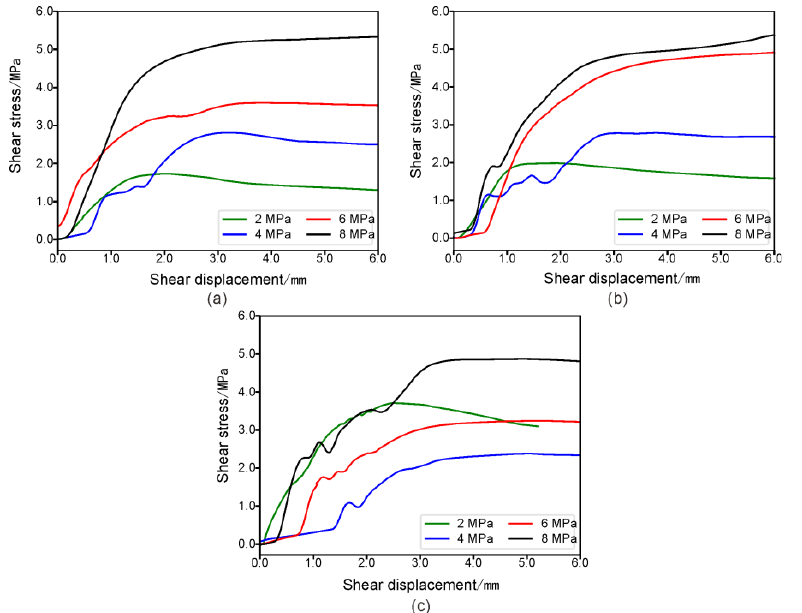
Figure 12. The shear stress–shear displacement curves of the tensile fault surface filled with three types of fault gouge (( a ) is No. 1 fault gouge, ( b ) is No. 2 fault gouge, ( c ) is No. 3 fault gouge).